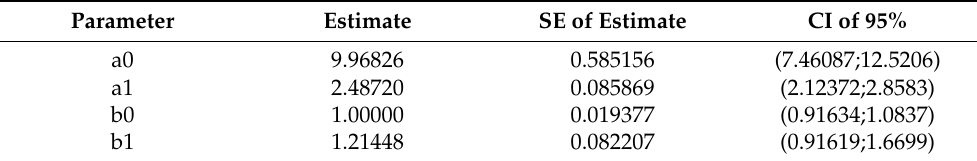
Table 4. Parameters calculations associated with Cu dissolution model.